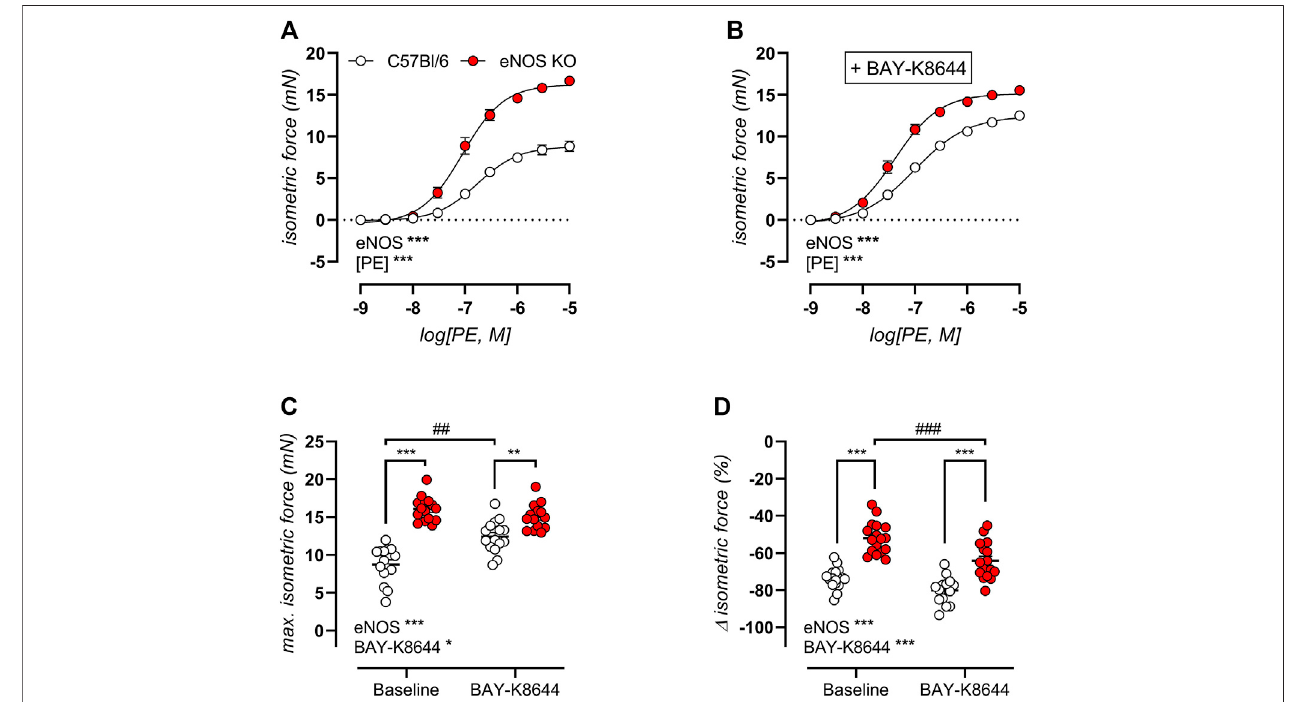
FIGURE5| AlteredVGCCfunctionineNOSknockoutmice.VGCCfunctionwasstudiedin6-montholdeNOSknockout( n =17)andC57Bl/6control( n =17)mice, using concentration-response PE-induced isometric contractions in the absence (A) and presence (B) of VGCC agonist BAY-K8644 (30 nM). The maximal effect of the concentration-response curves in (A) and (B) was calculated using a non-linear 4-parameter equation (C) . VGCC were subsequently inhibited by 35 µM diltiazem to assess the VGCC contribution to PE-induced isometric contractions (D) . Statistical analysis was preformed using two-way ANOVA. Overall signi fi cance (bottom left)andpost-hocsigni fi cance(ingraph)arelisted.Nopost-hocsigni fi canceislistedin (A,B) .Overallsigni fi canceandpost-hoctestforgenotype:*, p < 0.05;**, p < 0.01; ***, p < 0.001. Post-hoc test for BAY-K8644: ## , p < 0.01; ### , p < 0.001.